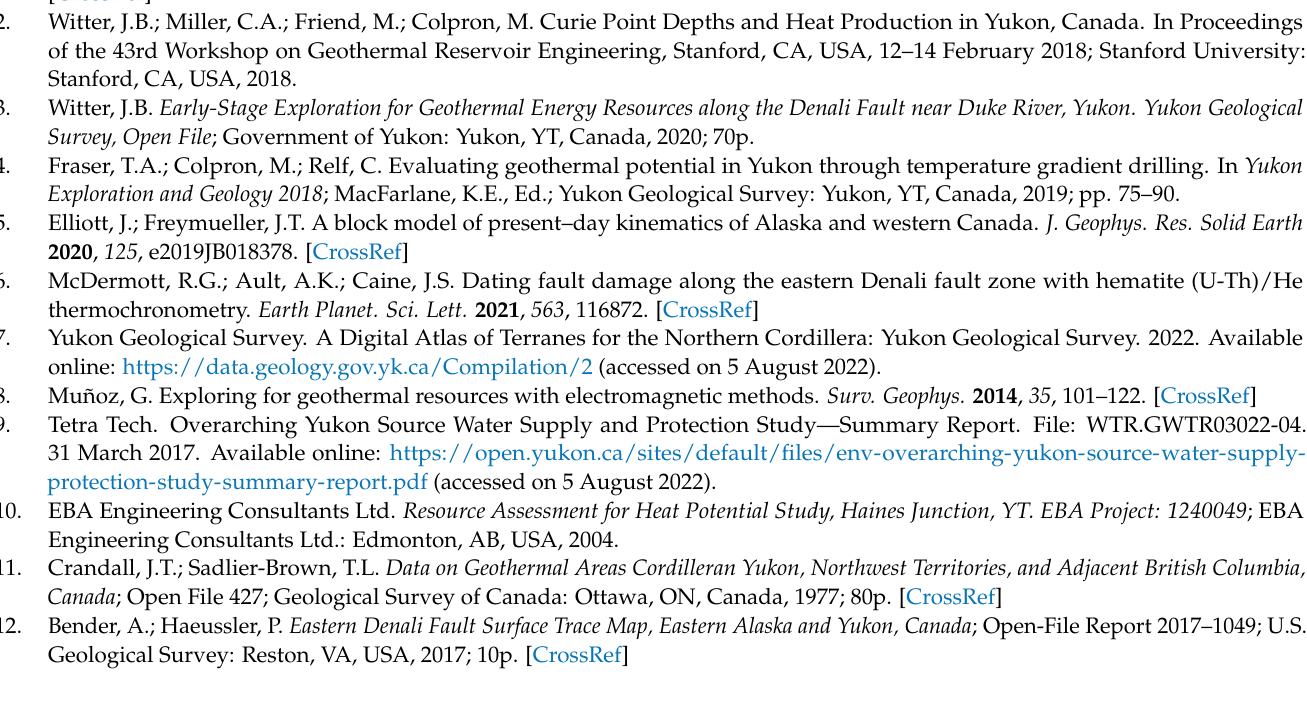
Figure S6: Sensitivity test on C3 by replacement with 200 Ω m background resistivity. (a) SW-NE cross-section showing the C3 feature test. (b) Apparent resistivity and phase as functions of period for closest sites to the C3 test. Solid and dashed lines show the results of forward response of preferred inversion and forward response with C3 replaced with a 200 Ω m body. Figure S7: Resistivity versus porosity for samples from Table 1. Table S1: Model parameter testing. Bold values were used for the preferred model (Figures 5 and